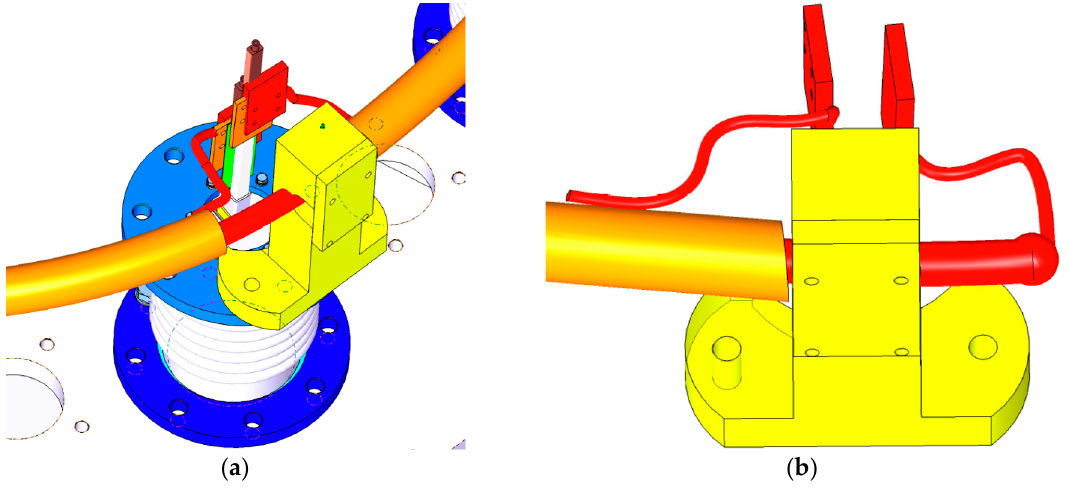
Figure 13. ( a ) Connection of the cable to a PFC on the top of the vessel; ( b ) Closure of the current path at the last PFC to minimize the undesired magnetic fields.